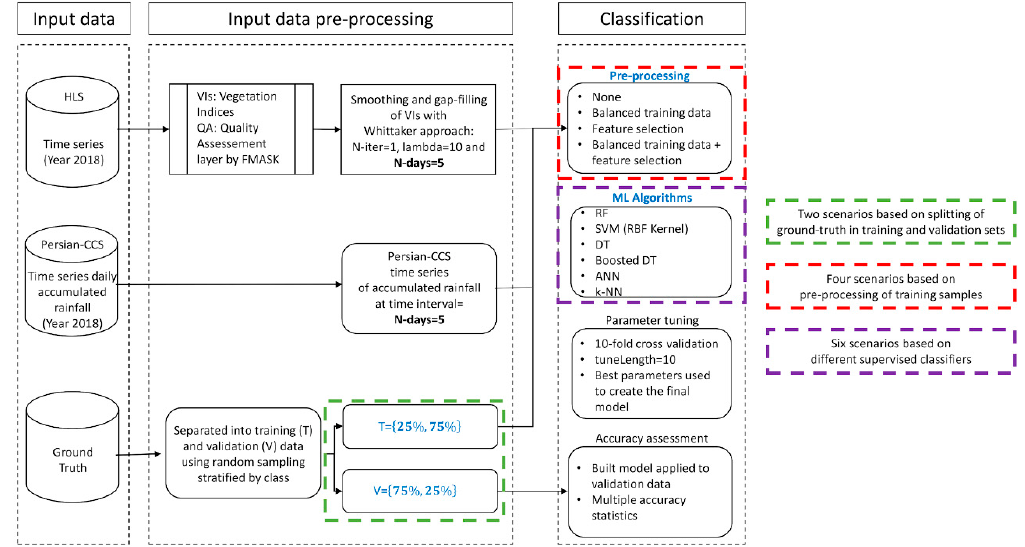
Figure 9. The framework of the overall experimental setting.